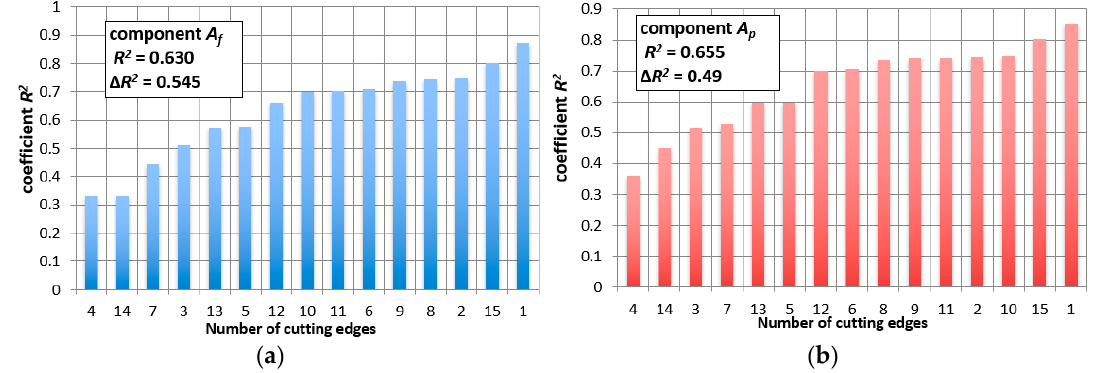
Figure 6. Matching coefficient R 2 for (a) the Af measure and (b) the Ap measure